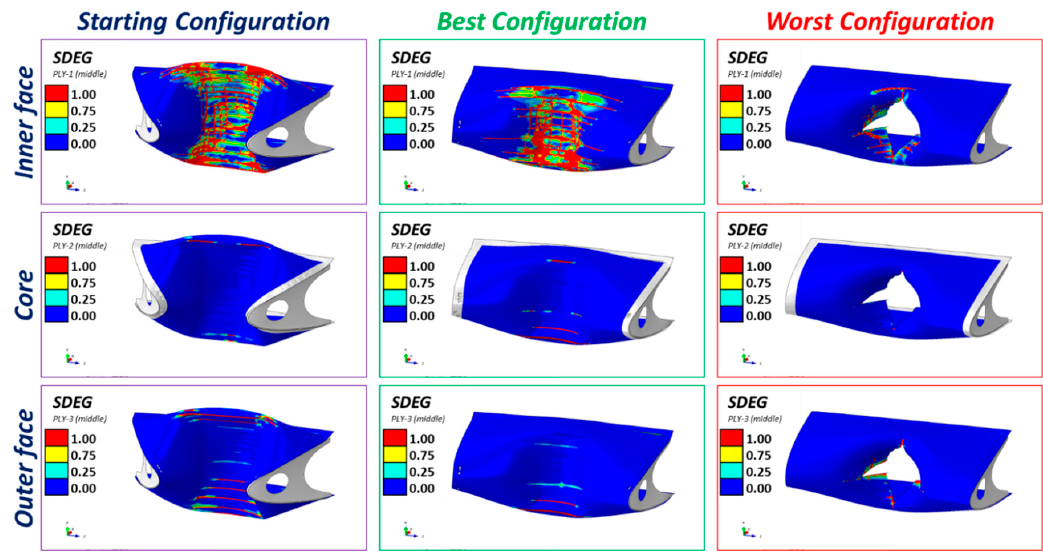
Figure 16. Degradation factor for inner and outer face and core for all investigated models.